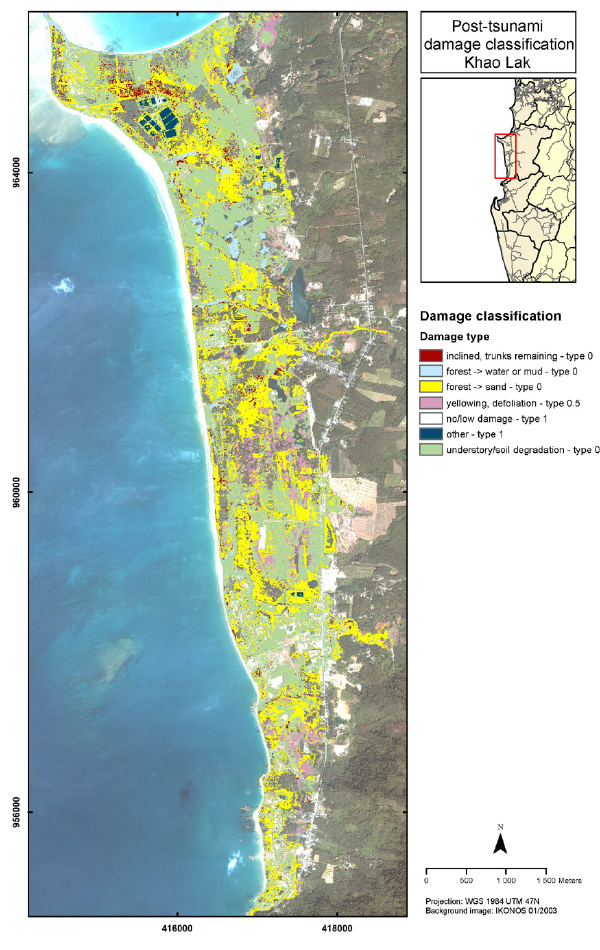
Fig. 4. Tsunami damage map for Khao Lak showing the spatial dis- tribution and the type of damages to vegetation directly after the tsunami in 2005. Beach erosion is not included in the map. Ar- eas with no/low damage are transparent. The method (Direct Multi- Date Classification) and data are described in Roemer et al. (2010). For the damage map applied in the ecosystem services maps, dam- age types have been summarised to type 1 (no damage), type 0 (total damage), and type 0.5 (indirect